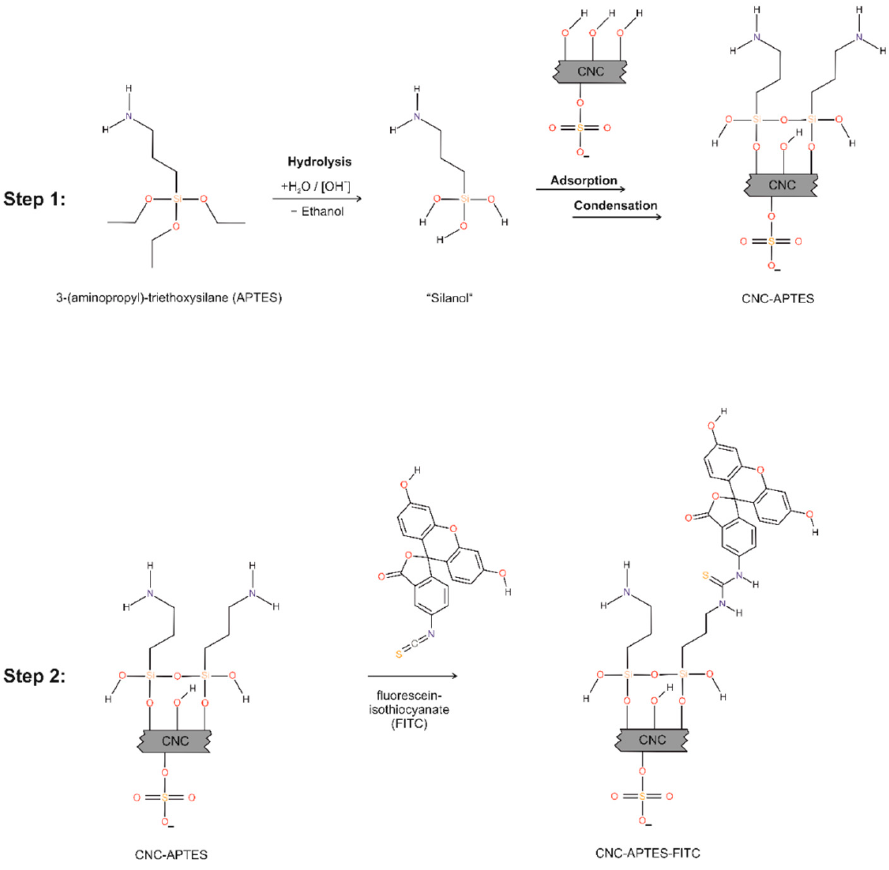
Figure 1. Reaction steps for synthesis of CNC-APTES and CNC-APTES-FITC.